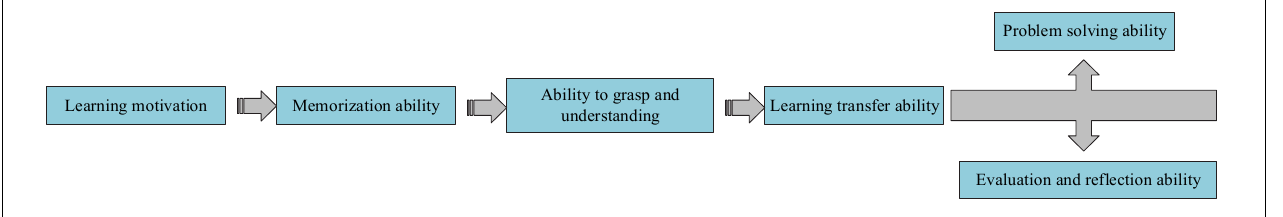
FIGURE 14 | Two paths for UGs’ DL. DL, deep learning; UG, undergraduate.